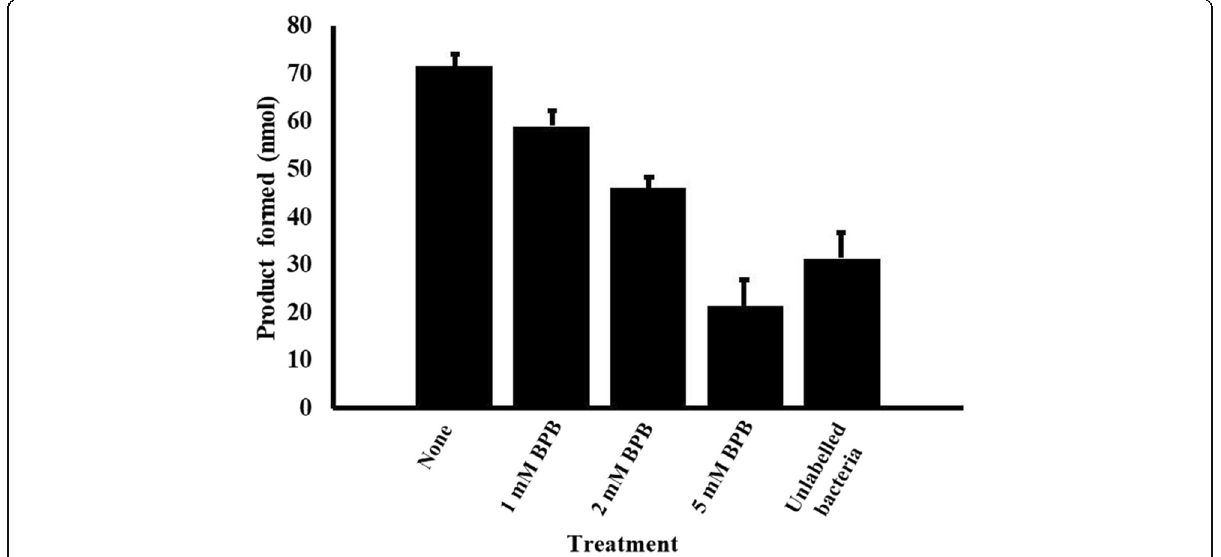
Fig. 4 Inhibition of the accumulation of fluorescent of product generated by plasma from Crotalus viridis . The addition of different amounts of BPB, a specific inhibitor of PLA 2 , resulted in a concentration-dependent inhibition of the accumulation of fluorescent fatty acid product. The results represent the means ± sd of four independent